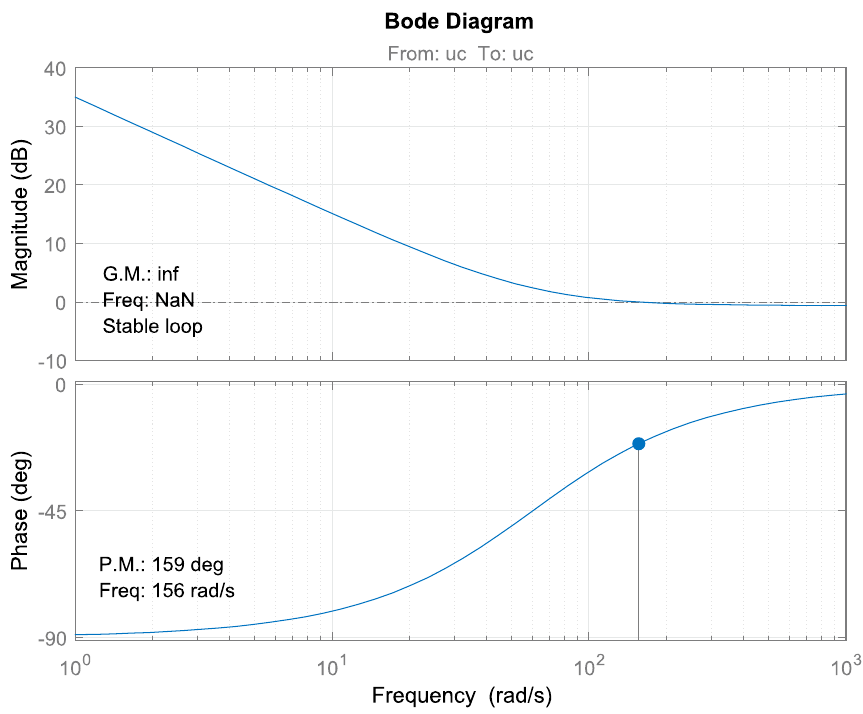
Figure 22. Frequency control loop Bode diagram.